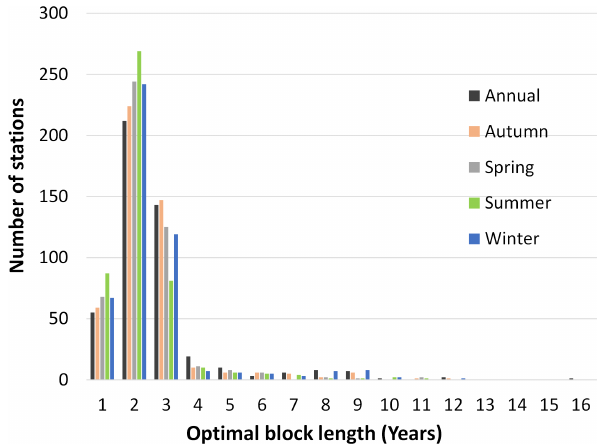
Figure 3. The optimal block length for the annual streamflow time series and the four seasonal streamflow time series for all 467 sta-